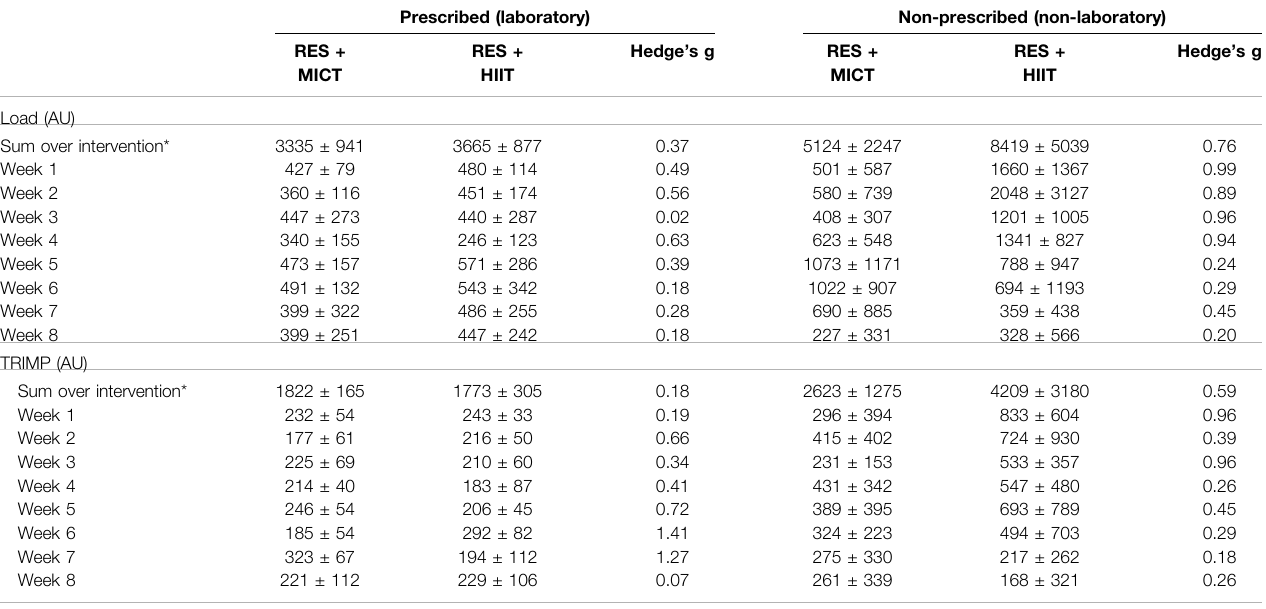
TABLE 2 | Training load metrics between RES + MICT and RES + HIIT conditions across the training interventions. Prescribed